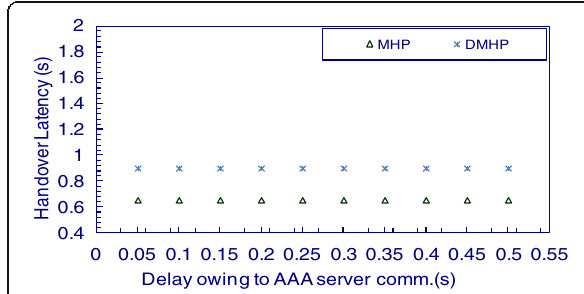
Fig. 12 Impact of AAA server delay on Handover delay of the DMHP and MHP